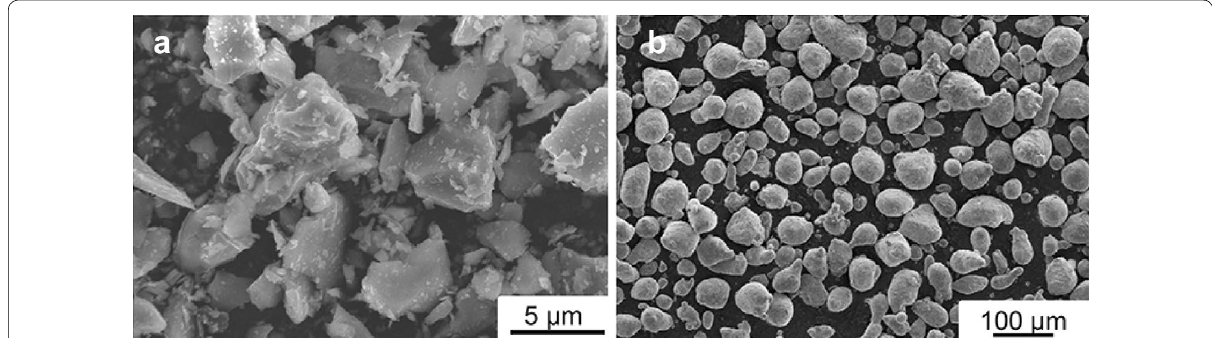
Figure 1 Morphologies of the powder materials: a Initial powder of the TiB 2 material; b the mixed 1 wt% micro-TiB 2 reinforced AlSi10Mg alloy powder after ball milling